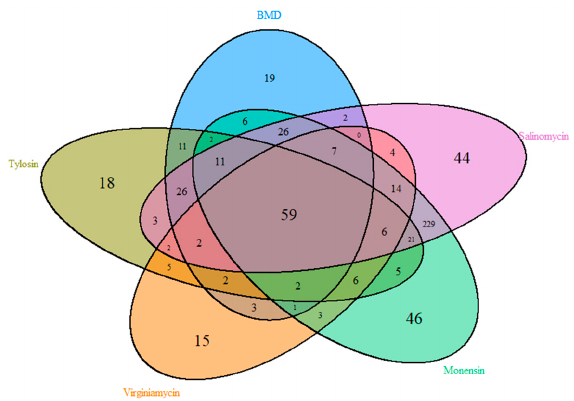
Figure 4. Differential enrichment of OTUs by in-feed antimicrobials. Significant up- or down-regulation of OTUs was determined using Metastats [23], relative to the control group ( p ≤ 0.05). Venn diagram was then used to visualize the distribution of shared OTUs among individual antimicrobials.